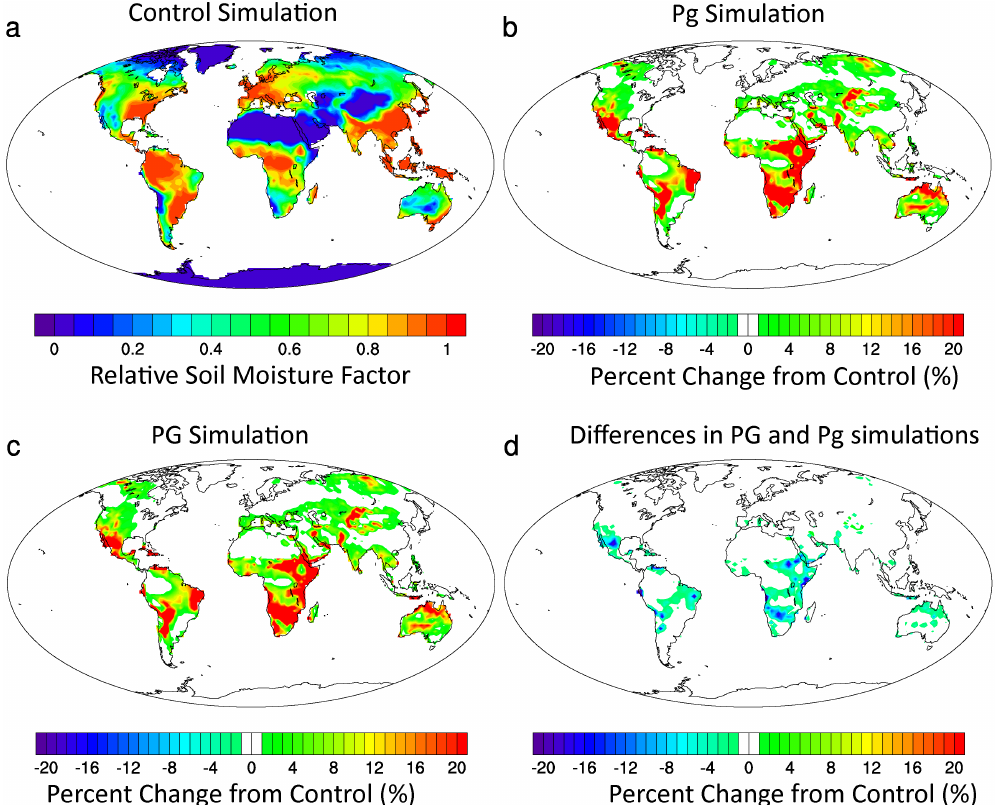
Fig. 8. Mean relative soil moisture factor predicted in 20-yr CLM simulations run at 100ppb O 3 . The control simulation (a) shows the average relative soil moisture factor in the absence of O 3 on a scale of 0 (driest) to 1 (wettest). The percent changes from control were mapped for the (b) Pg simulation, where a direct change in photosynthesis causes changes in conductance and for the (c) PG simulation, where direct changes to photosynthesis and conductance occur independently. Panel (d) illustrates the differences in relative soil moisture between the PG compared to the Pg simulation, also mapped as a percent change from